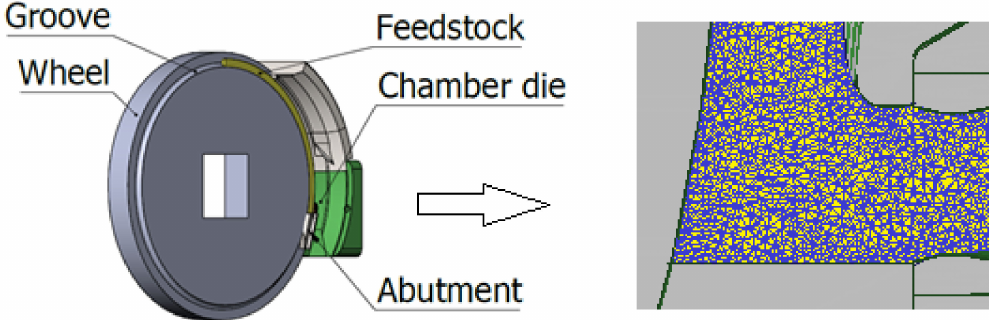
Figure 1. Schematic representation of the Conform severe plastic deformation (SPD)